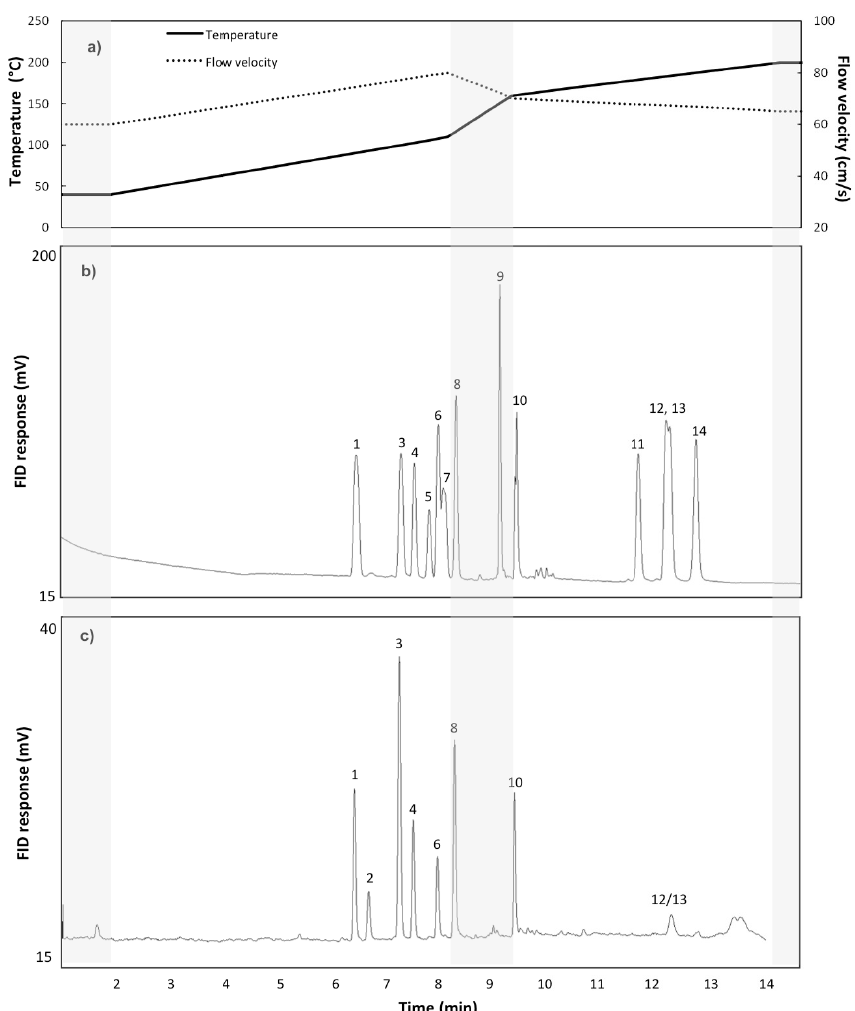
Fig. 2. (a) shows the temperature and carrier gas flow velocity programmes used for the GC_CHAMBER method. (b) shows a chro- matographic trace recorded using the GC_CHAMBER method for analysis of BVOC in liquid standard ( ∼ 2.0–8.0mgL − 1 terpenes in isop-propyl alcohol). (c) is a chromatogram resulting from analysis of BVOC in air during a white spruce ( Picea glauca ) plant emis- sion study (see Sect. 3.1 for details). Chromatographic peaks correspond to the following BVOC; α -pinene(1), camphene(2), β -pinene(3), myrcene(4), α -phellandrene(5), 1 -3-carene(6), α -terpinene(7), limonene(8), linalool(9), limonene oxide(10), α -copaene(11), α -cedrene(12), β -caryophyllene(13), α -humulene(14). Alternate shaded regions highlight changes in chromatography parameters (for more details, see Table